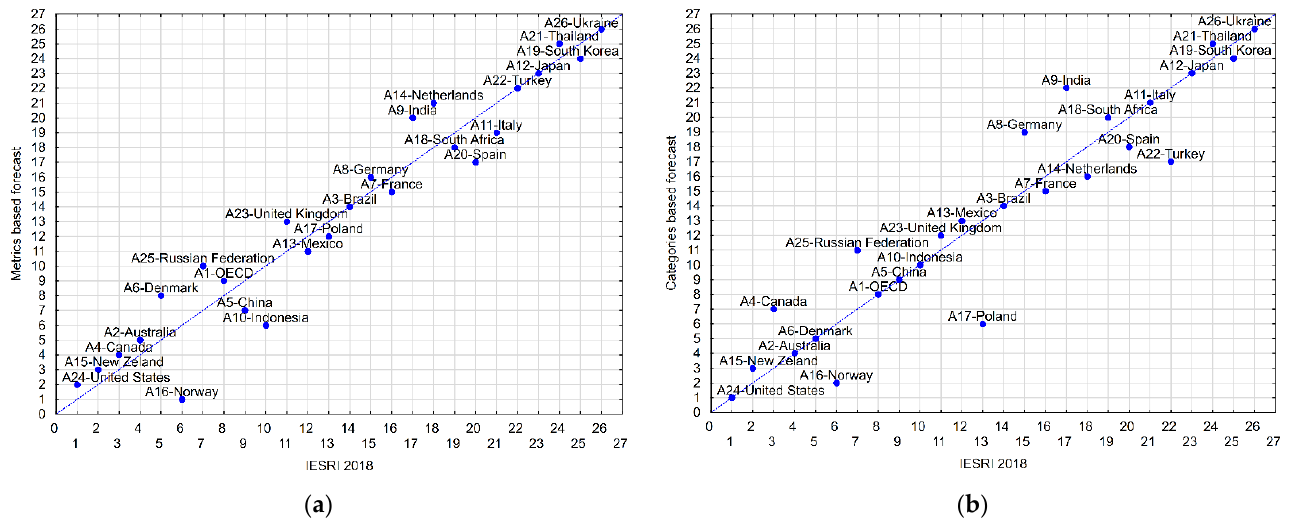
Figure 5. Scattering chart between the current IESRI ranking and the forecasted rankings obtained from: ( a ) metrics; ( b ) categories.